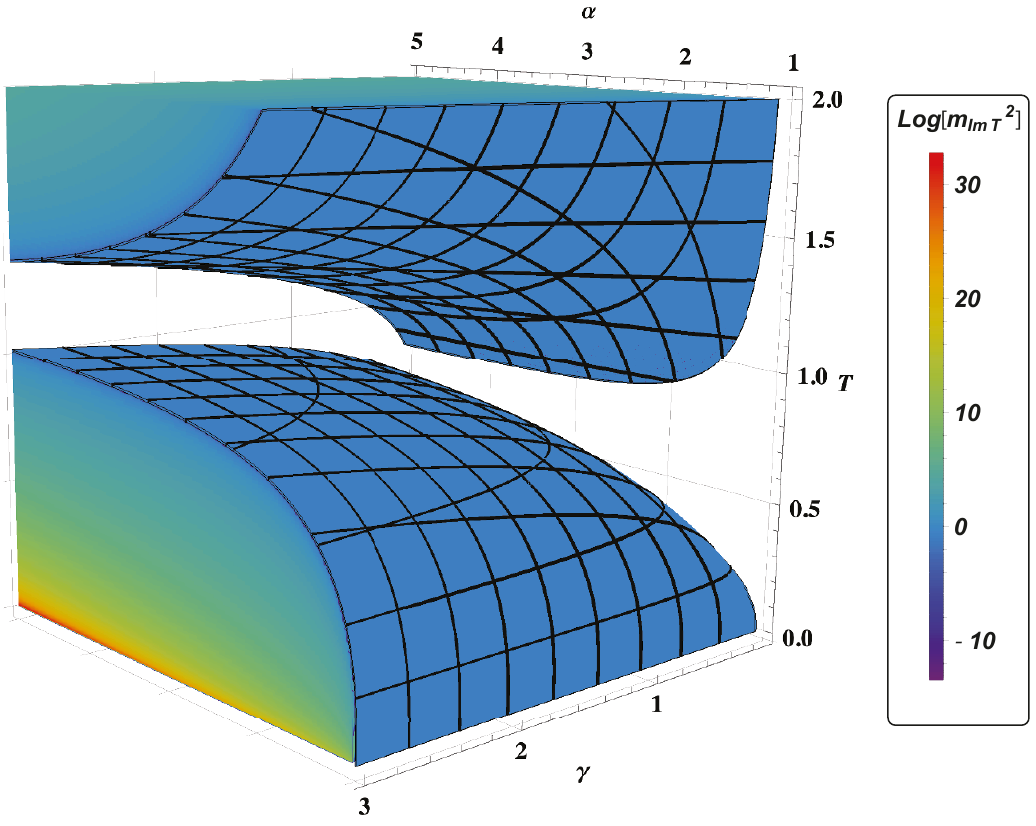
Figure 1. Illustration of the value of the expression (2.34) as a function of ( α, γ, T ), as shown by the color coding for log